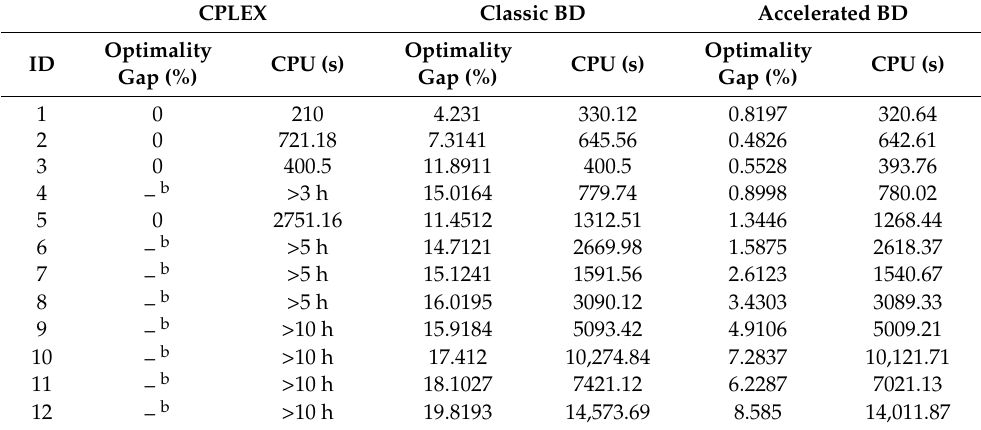
Table 6. A comparison of the proposed accelerated Benders’ Decomposition (BD) to classic BD and CPLEX, for small, medium, and large size test